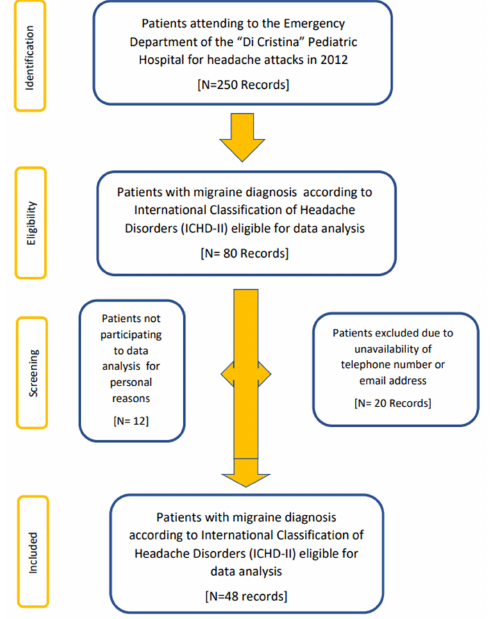
Figure 1. Flow chart diagram of subject selection.